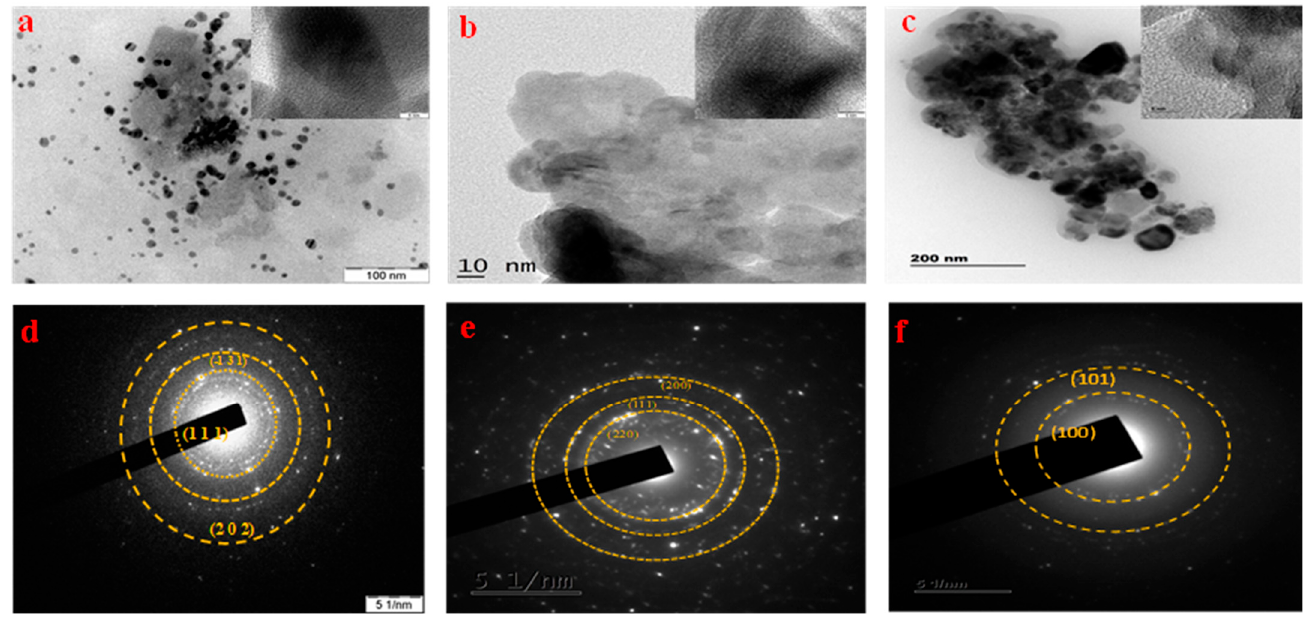
Figure 4. TEM analysis and SAED pattern of synthesized photocatalyst: ( a , d ) CuO; ( b , e ) NiO; ( c , f ) ZnO.